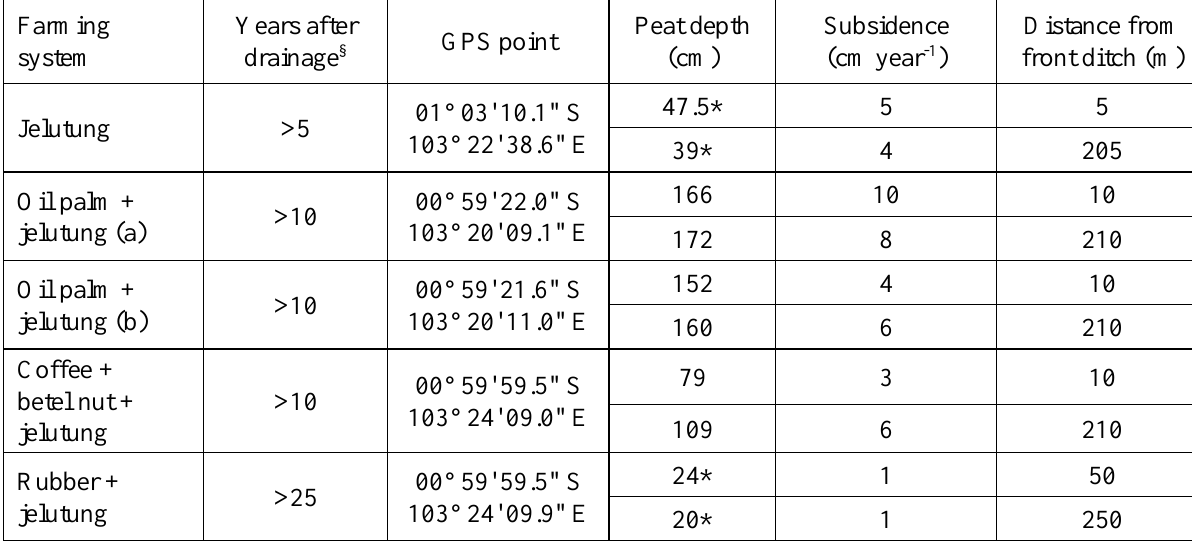
Table 2. Peat depths and subsidence rates at four mixed farming systems in Tanjabar (Jambi). Notes: * = peaty soil; § = the information was given by key informants in the field.